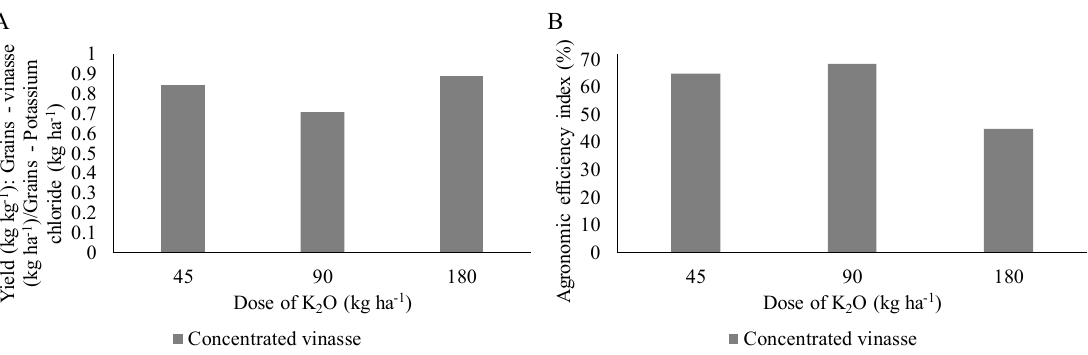
Figure 5. Comparison of produced yield between concentrated vinasse and potassium chloride ( A ) and the agronomic efficiency index of concentrated vinasse ( B ).